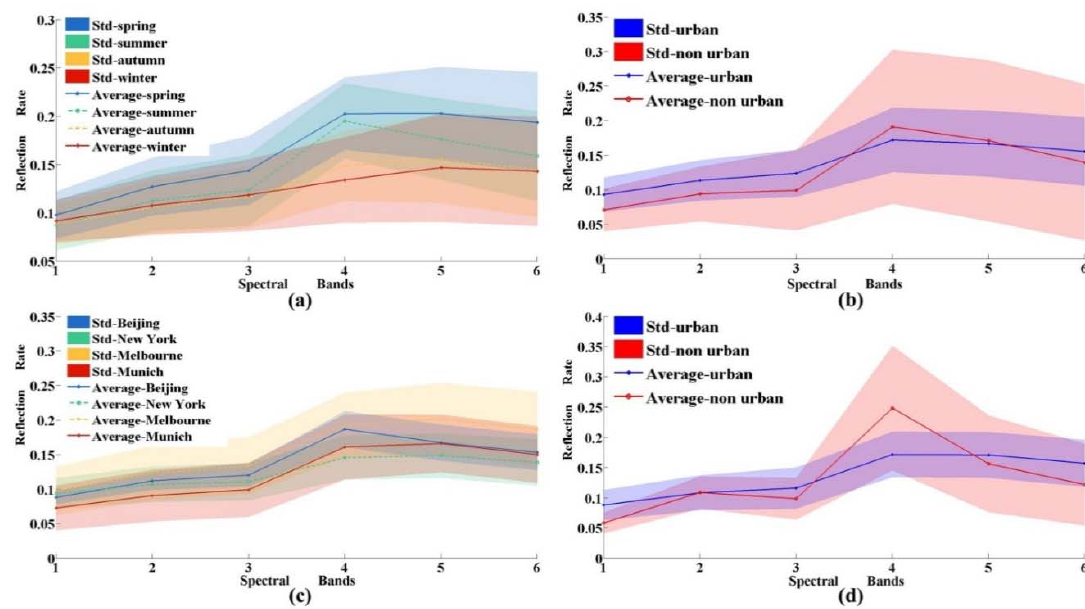
Figure 12. Spectral curves for urban and non-urban areas in different seasons and study areas: ( a ) spectral curves for urban areas during different seasons in Beijing; ( b ) annual mean spectral curves for urban and non-urban areas in Beijing; ( c ) spectral curves for four urban areas in the four analyzed cities acquired at similar day of year; and ( d ) spectral curves for urban areas averaged over the four analyzed cities.